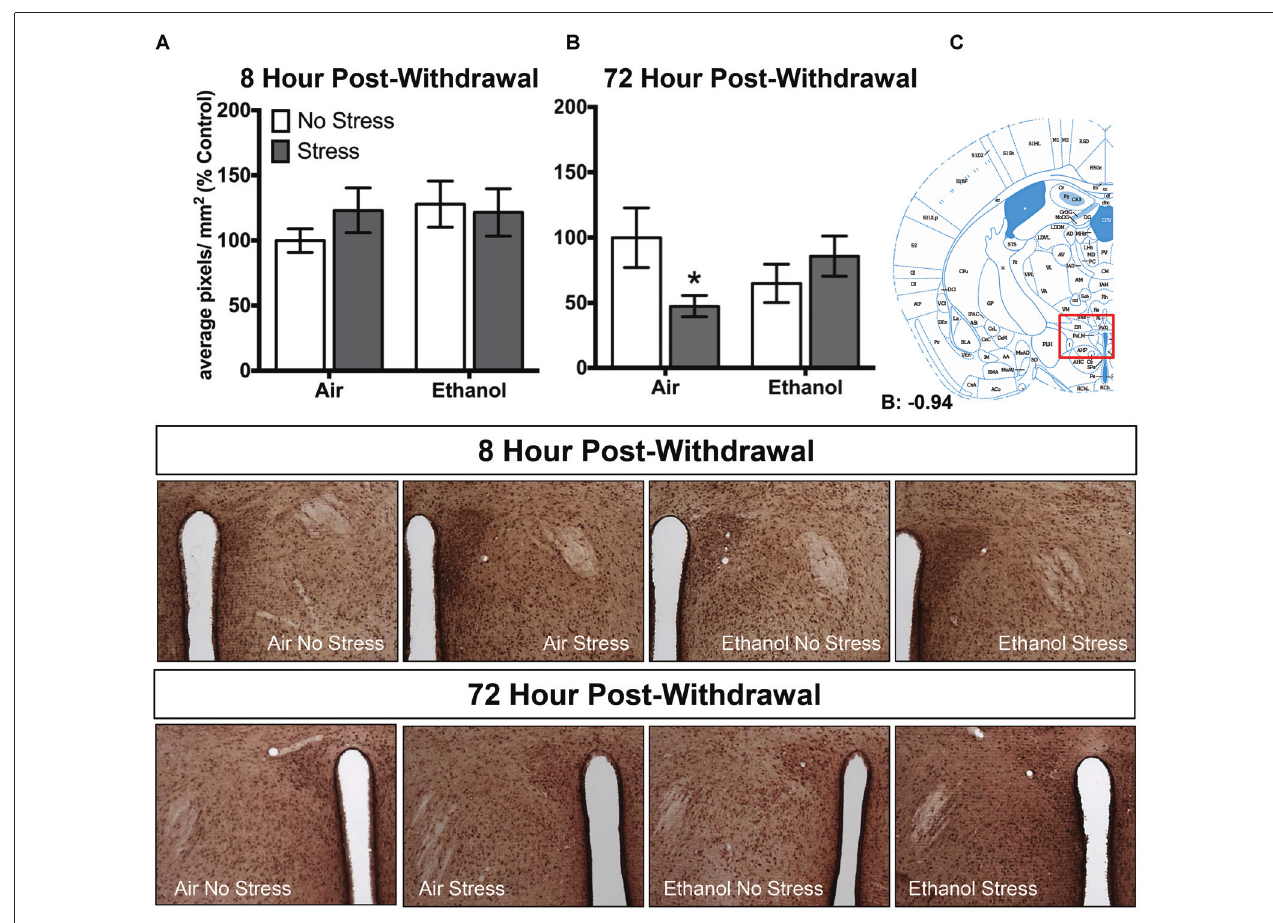
FIGURE 4 | Effects of CIE or air exposure on 3 α ,5 α -THP immunoreactivity in the paraventricular nucleus of the hypothalamus following (A) 8 h or (B) 72 h post-withdrawal in non-stressed (clear bars) or stressed mice (gray bars) . Data depicted are mean positive pixels/mm 2 expressed as percent control ± SEM. (C) Red box indicates coordinates relative to bregma depicted in photomicrographs. Representative photomicrographs (10x) of 3 α ,5 α -THP immunoreactivity 72 h post-withdrawal following CIE and/or stress exposure. ∗ p < 0.05 compared to Air-No Stress group.